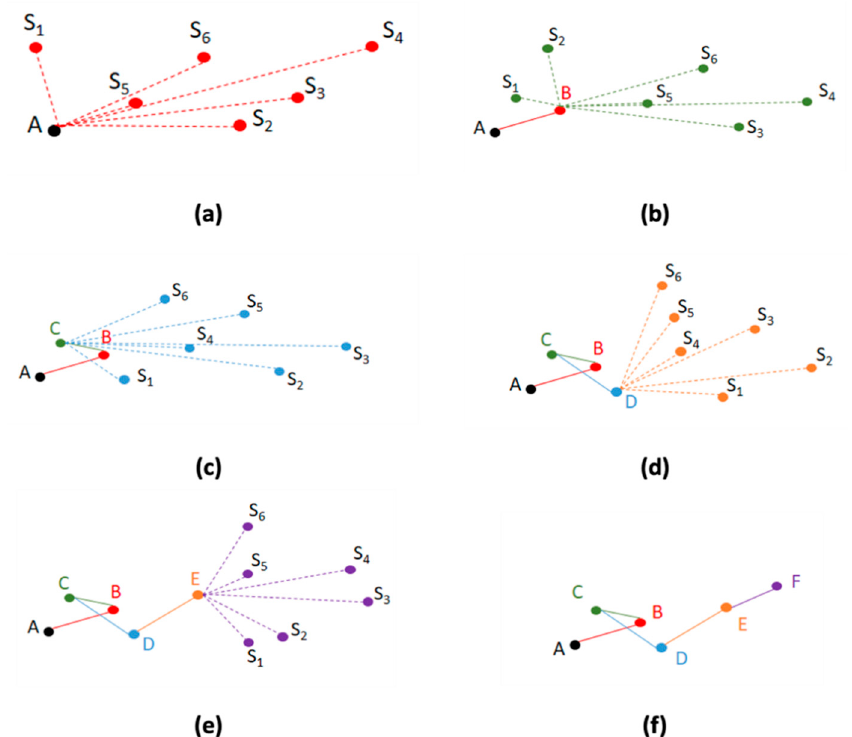
Figure 17. The steps of NNS method: ( a ) the first component placing position A with other possible second component placing positions S1-S6; ( b ) B is selected for the nearest distance from A as a second component placing position; ( c – f ) Continue the selecting process until all the placing positions are determined.